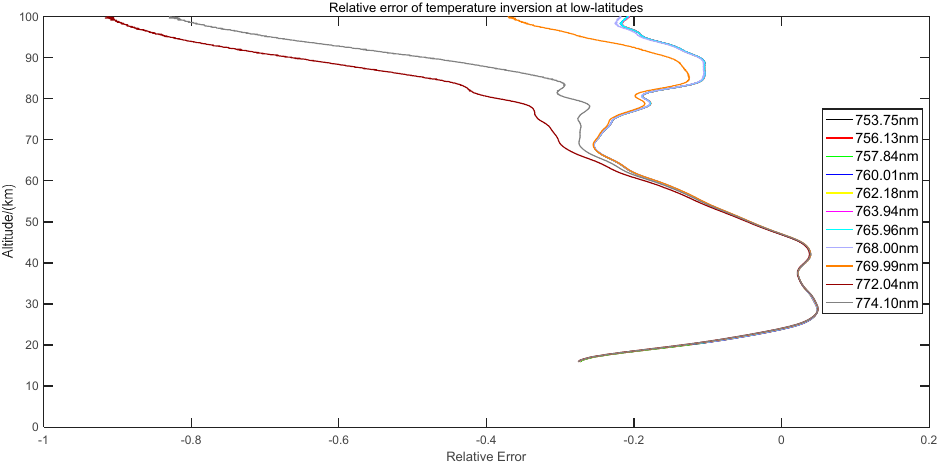
Figure 9. Relative deviation of temperature inversion results at different wavelengths.